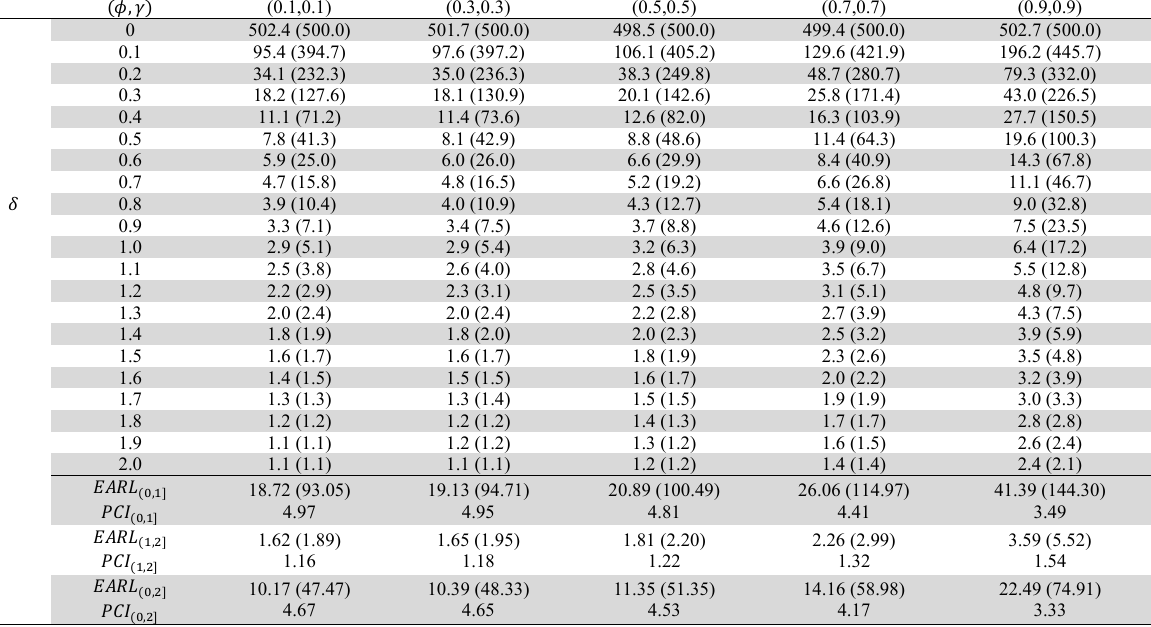
=500 and ( 𝜙 , 𝛾 ) ∈ {(0.1,0.1),(0.3,0.3), (0.5,0.5), (0.7,0.7), (cid:2868)